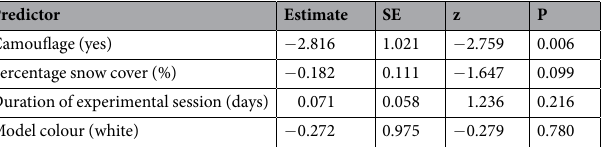
Table 2. Effect of camouflage (camouflaged or not), area covered with snow (0–100%), duration of experimental session (days) and model colour (brown or white) on weasel model detection. Results were based on generalized linear mixed models (GLMM), with binomial distribution for the dependent variable.